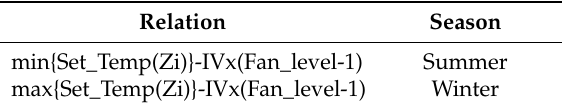
Table 3. Configuration of the set-point temperature of the indoor unit (Output_Temp).